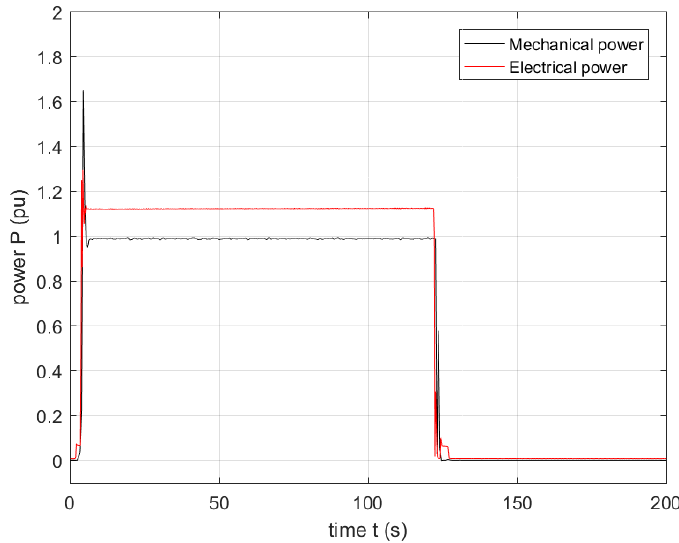
Figure 17. Electrical power delivered to the motor inverter vs. mechanical power on the motor shaft – lifting the weight, defined in the per-unit system (p.u.).